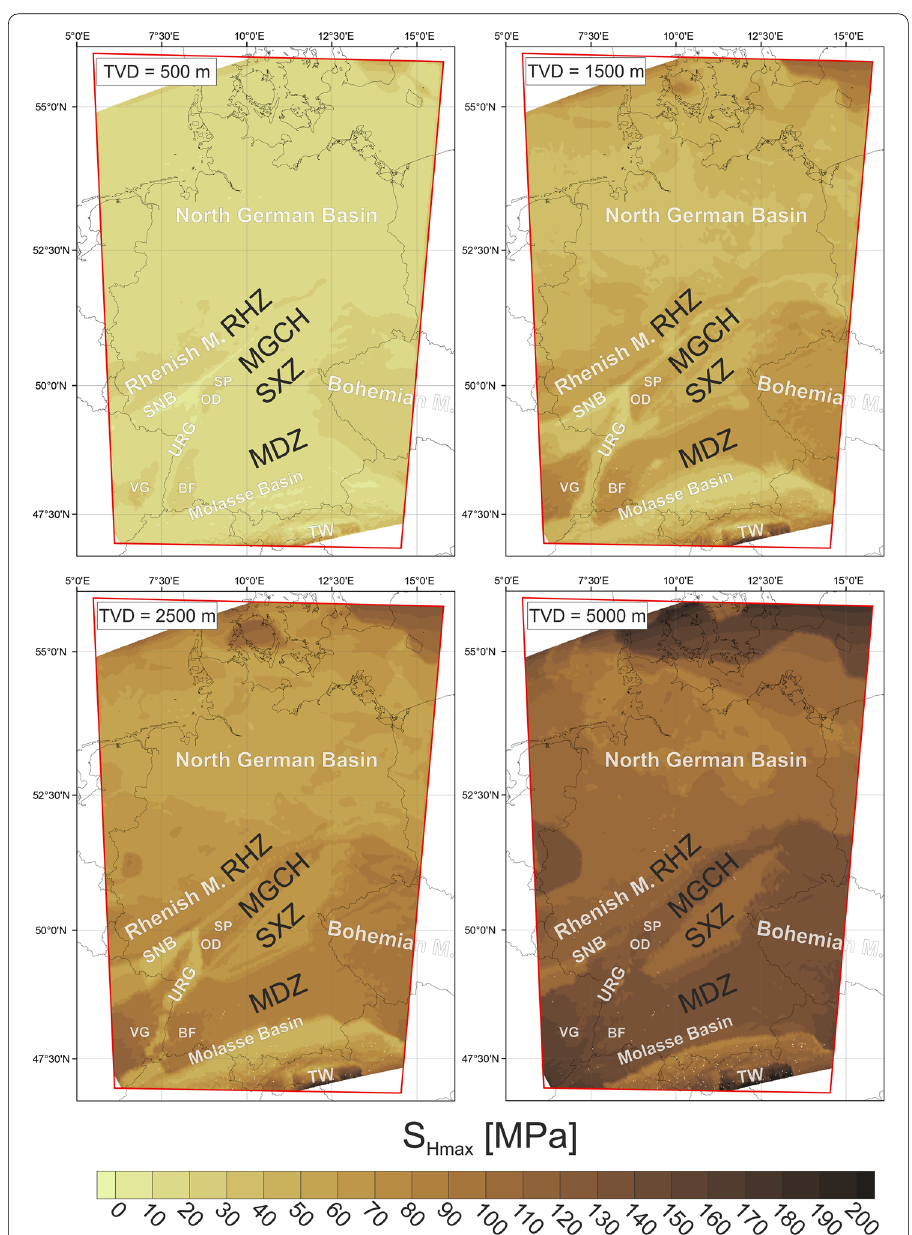
Fig. 9 Depth sections showing the lateral distribution of the S Hmax magnitudes predicted by the model at four depth sections. TVD—true vertical depth. Black titles (details in Fig. 1d): MDZ—Moldanubian Zone, MGCH—Mid German Crystalline High, RHZ—Rhenoherzynian Zone, SXZ—Saxothuringian Zone. White titles (details in Fig. 1c): BF—Black Forest, M—Massif, OD—Odenwald, SNB—Saar–Nahe Basin, SP—Spessart, TW— Tauern Window, URG—Upper Rhine Graben,